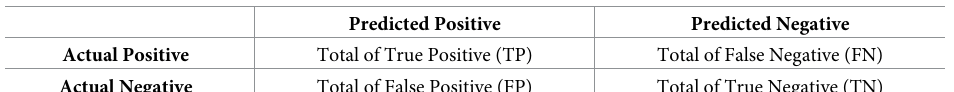
Table 2. Confusion